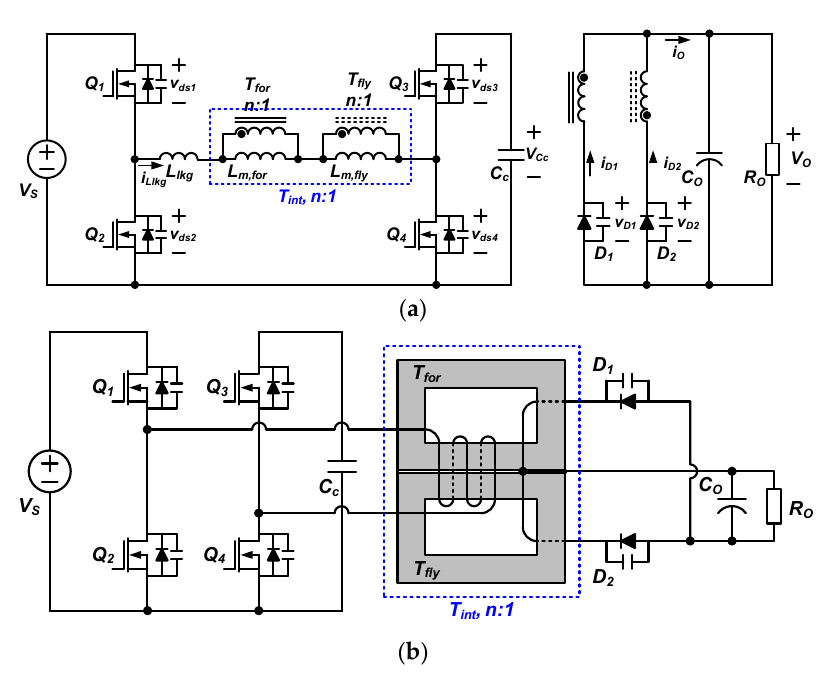
Figure 4. Proposed converter. ( a ) Circuit diagram. ( b ) Circuit diagram with a proposed integrated transformer.